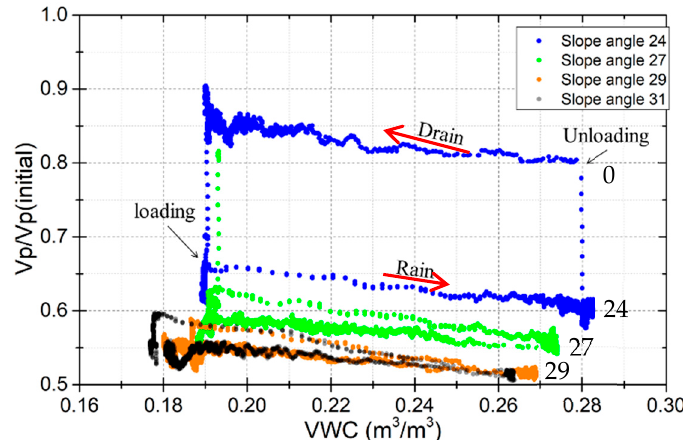
Figure 13. Wave velocities ratio changes with slope angle at the survey line between receivers ch12 and ch13.